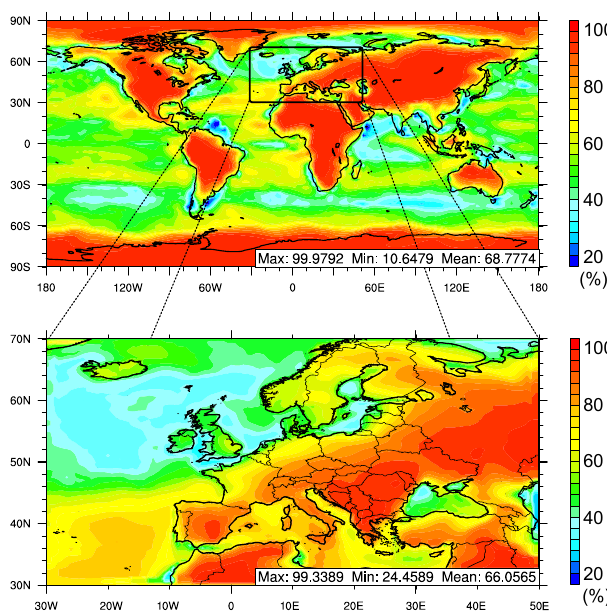
Figure 4. Percentage of the submicron MOA concentration pre- dicted by GEOS-Chem to be hydrophilic (aged) for July 2009.